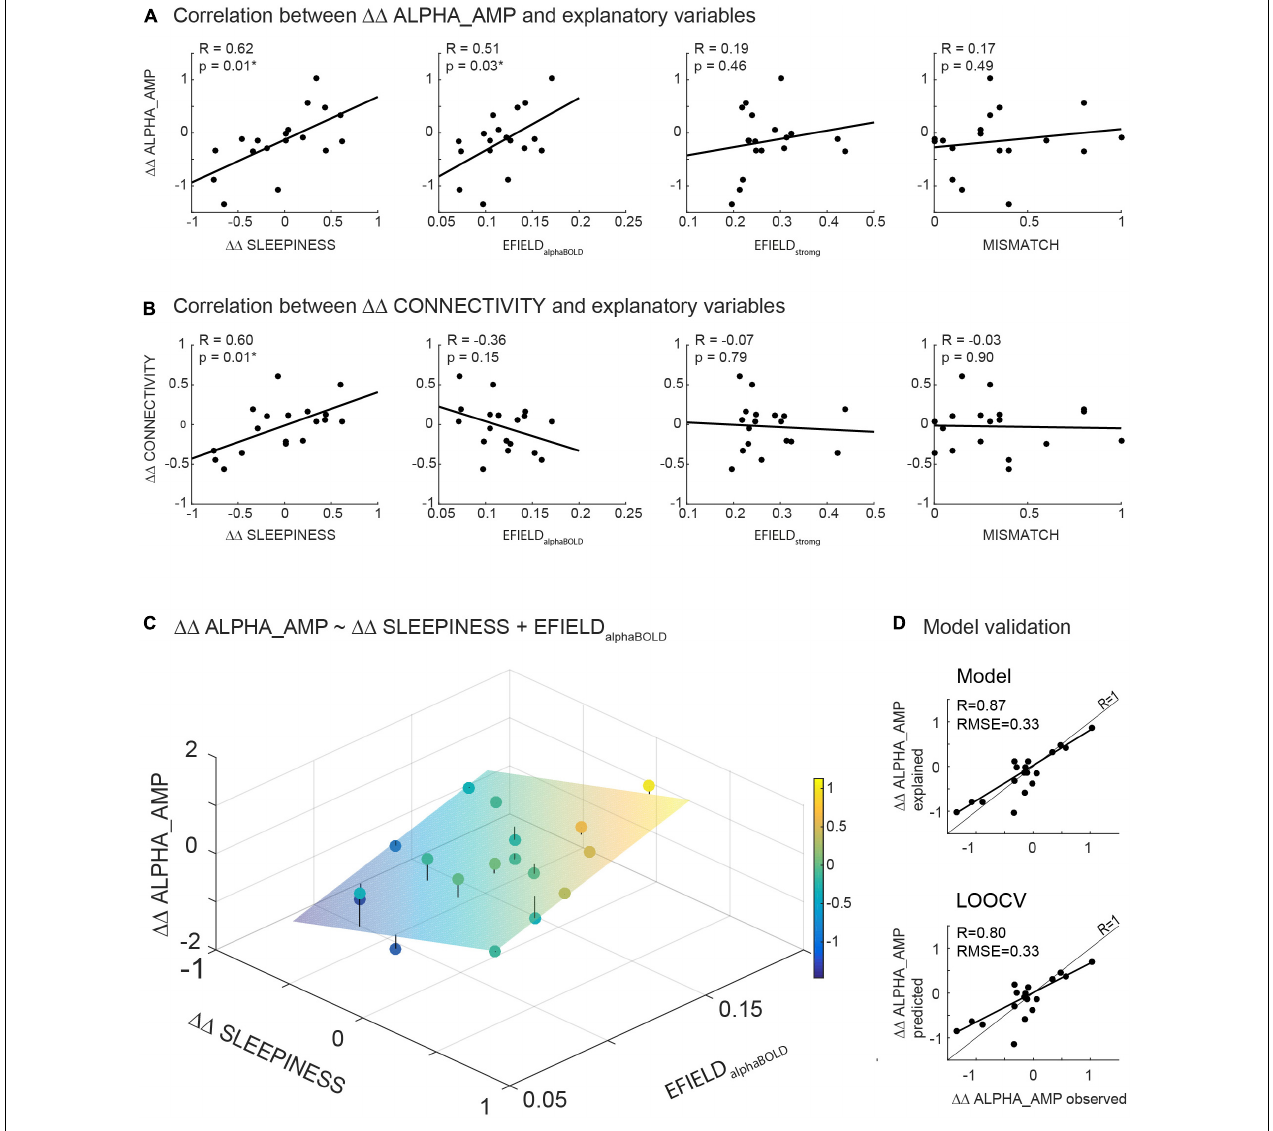
FIGURE 5 | (A,B) Illustrates the results of correlations calculated between the readout variables ( (cid:49)(cid:49) ALPHA_AMP resp. (cid:49)(cid:49) CONNECTIVITY) and potential modulating variables ( (cid:49)(cid:49) SLEEPINESS, MISMATCH, EFIELD alphaBOLD and EFIELD strong ). (C) Illustrates the result of the significant model ( (cid:49)(cid:49) ALPHA_AMP ∼ (cid:49)(cid:49) SLEEPINESS + EFIELD alphaBOLD ) in a three-dimensional plot: The scatter plot represents the observed (cid:49)(cid:49) ALPHA_AMP, while the plane shows the calculated (cid:49)(cid:49) ALPHA_AMP based on the parameter estimated in the model. (D) Depicts the observed (cid:49)(cid:49) ALPHA_AMP in relation to estimated (cid:49)(cid:49) ALPHA_AMP based on the model fit (upper part) resp. to (cid:49)(cid:49) ALPHA_AMP predicted by the leave-one-out cross validation (LOOCV)